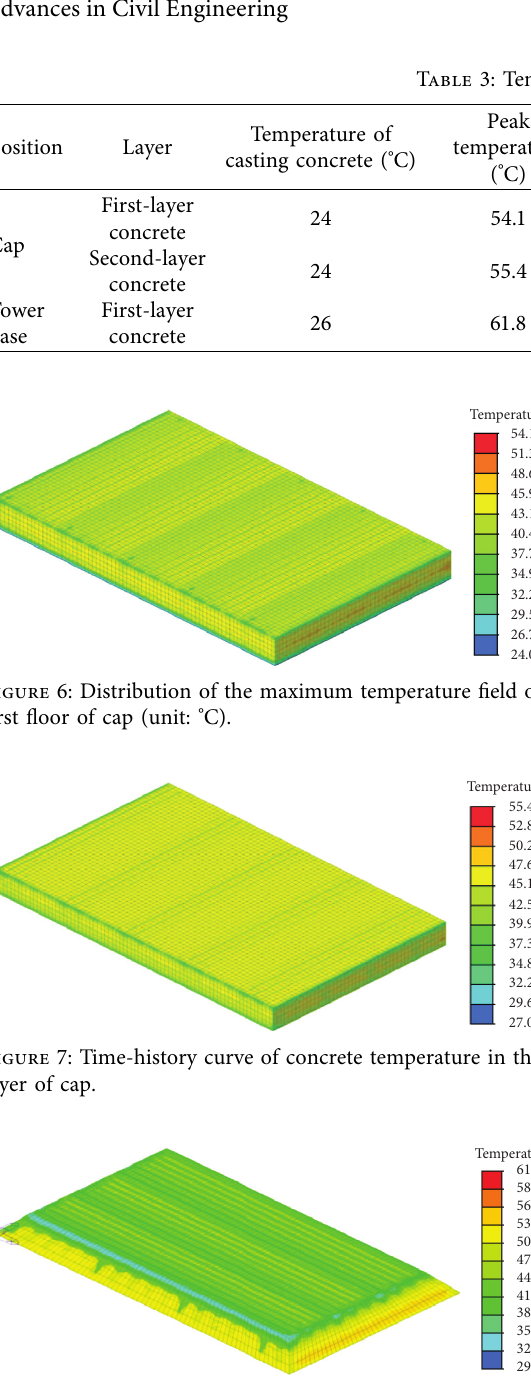
Figure 8: Distribution of maximum temperature field on the second floor of cap (unit: ° C).